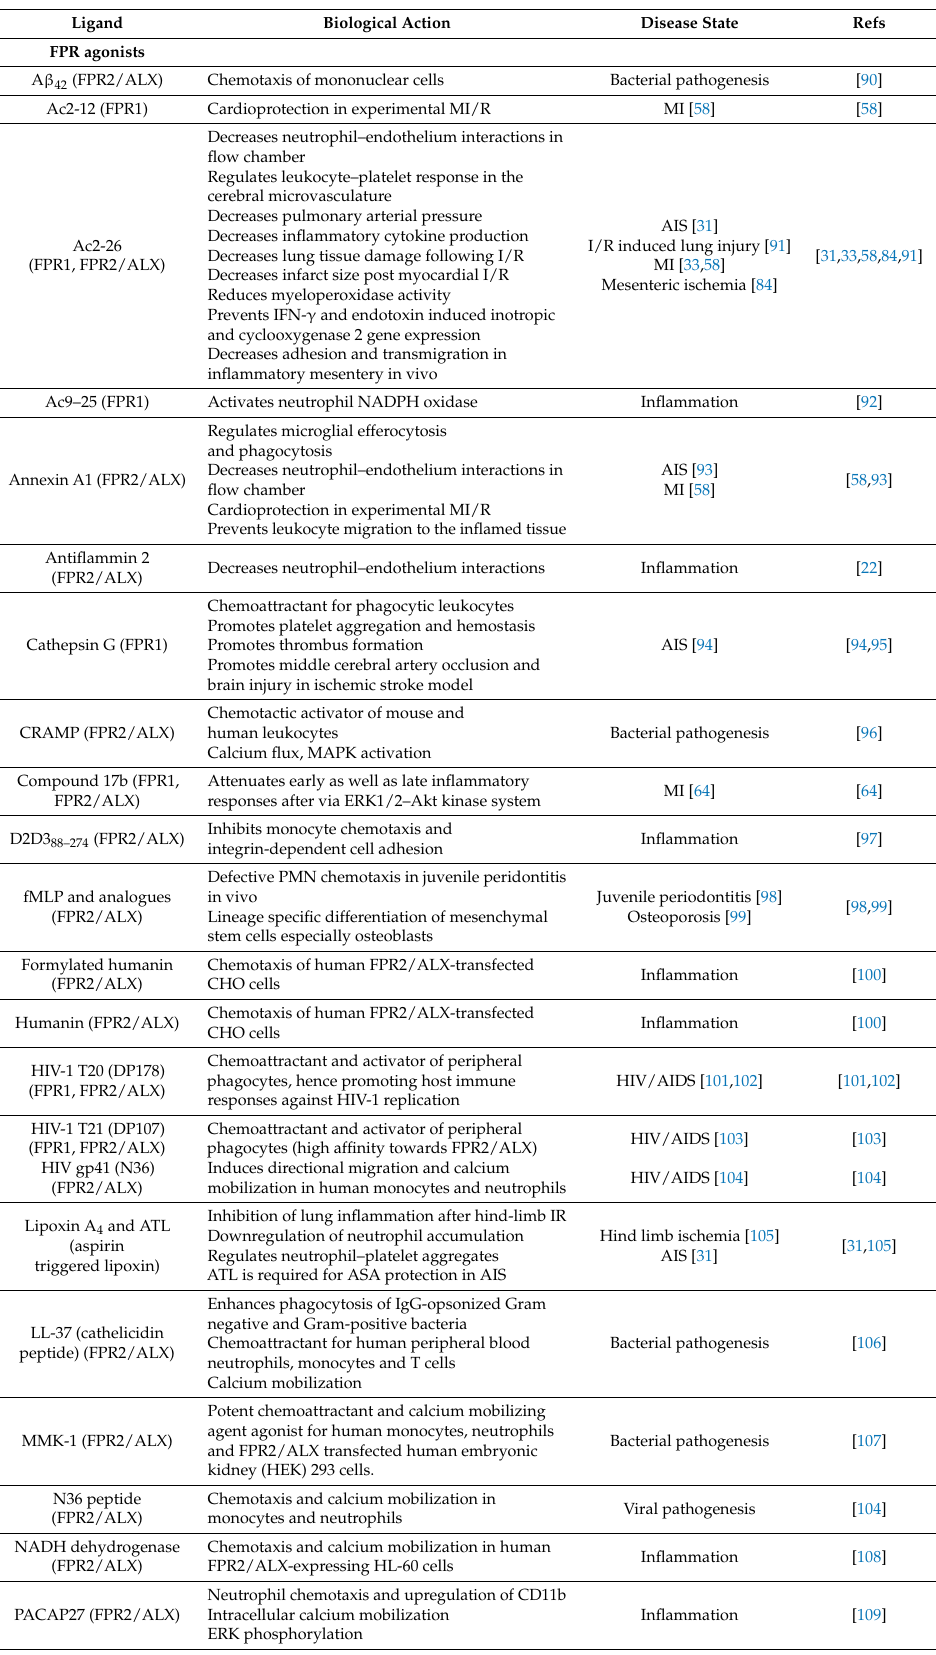
Table 2. Non-exhaustive list of FPR ligands and their biological